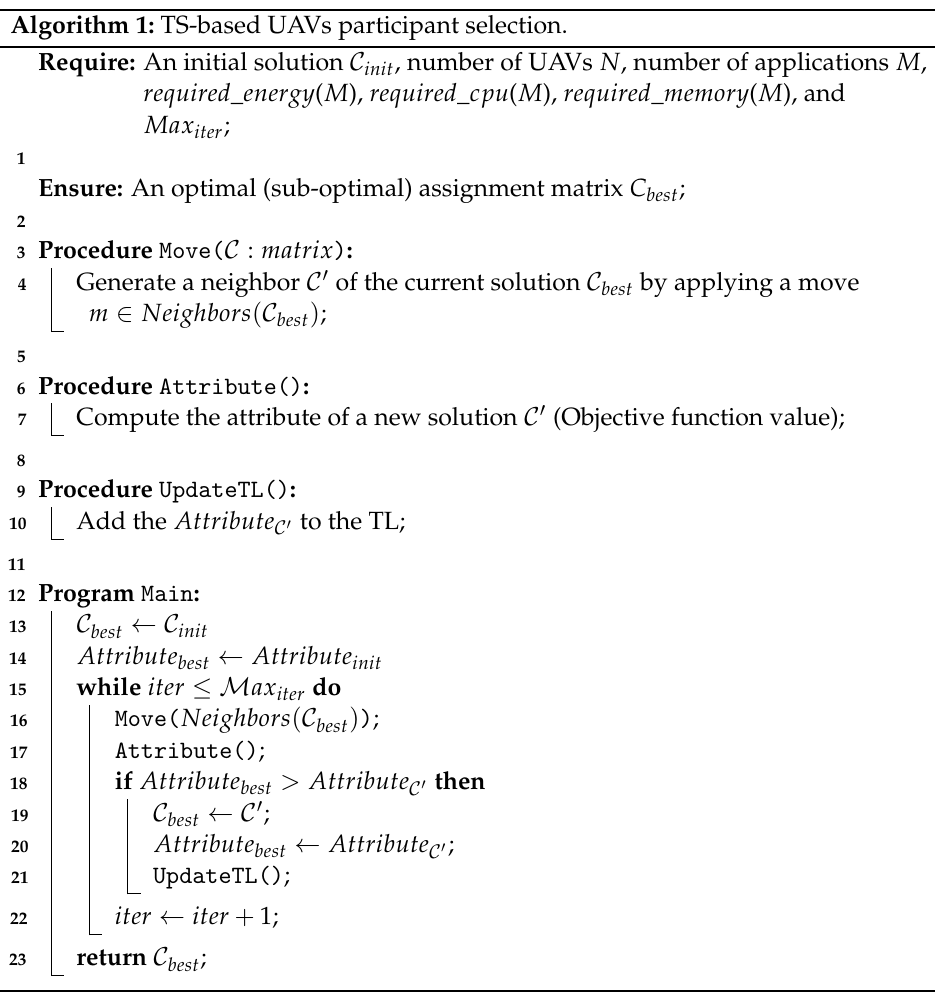
Algorithm 1: TS-based UAVs participant